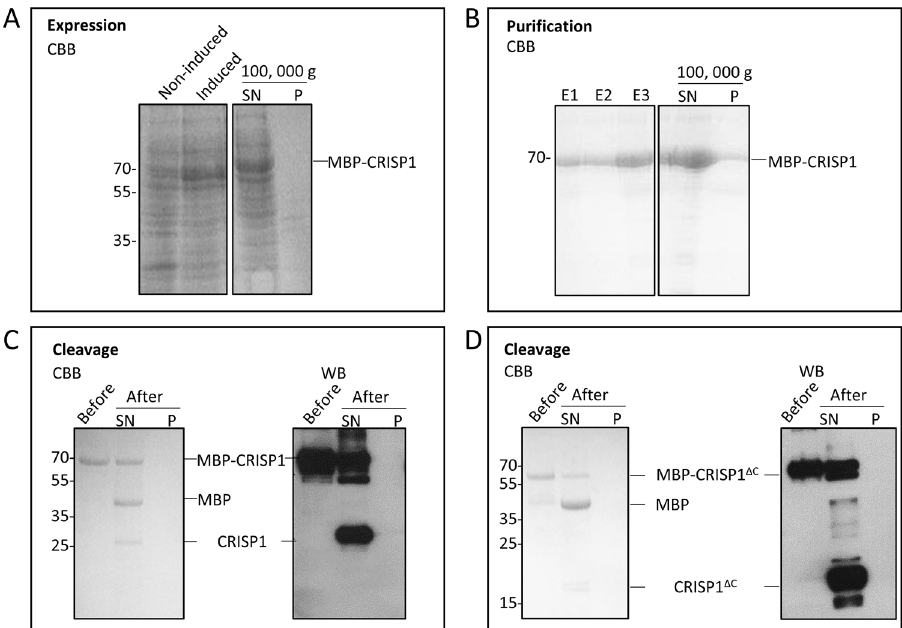
Figure 2. Expression and purification of CRISP1/CRISP1 ΔC in XL-1 Blue bacteria. ( A ) Expression of MBP- CRISP1. Samples before (Non-induced) or after induction (Induced) with IPTG were centrifuged at 100,000 g and the supernatant (SN) and pellet (P) of induced samples were analyzed by SDS-PAGE and Coomassie Brilliant blue (CBB). ( B ) Purification of MBP-CRISP1. MBP-CRISP1 was eluted with maltose (elution fractions (E1-E3)). Elution fraction E3 was centrifuged at 100,000 g and the supernatant (SN) and pellet (P) were analyzed by SDS-PAGE and Coomassie Brilliant blue. ( C , D ) Cleavage of MBP-CRISP1 and MBP-CRISP1 ΔC . Before and after cleavage of MBP-CRISP1 ( C ) and MBP-CRISP1 ΔC ( D ) with Factor Xa, the fractions were centrifuged at 100,000 g and the supernatant (SN) and pellet (P) were analyzed by SDS-PAGE and Coomassie Brilliant blue staining or Western blotting